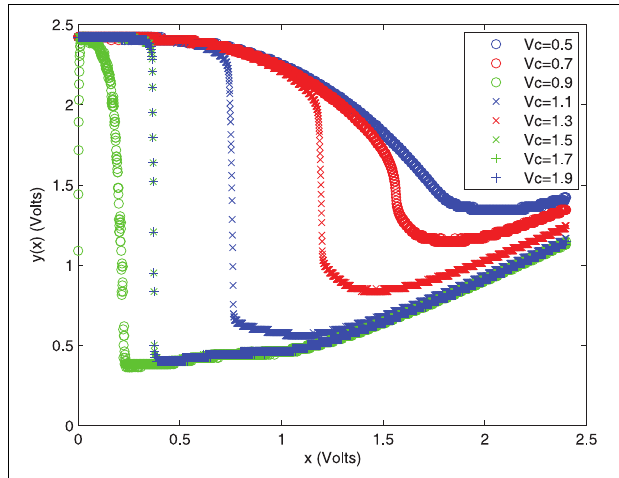
FIGURE 7 | Measured y(x) voltage vs. V c for the chaos map circuit compiled on the